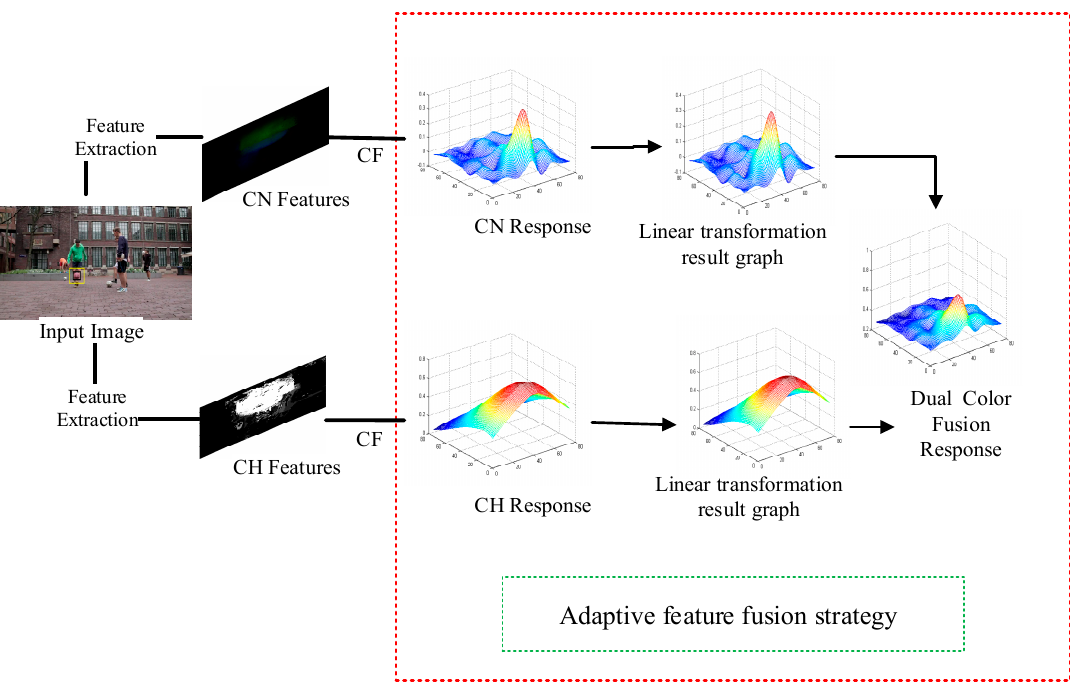
Figure 2. Feature fusion flow chart. CF denotes the Correlation Filter operation.